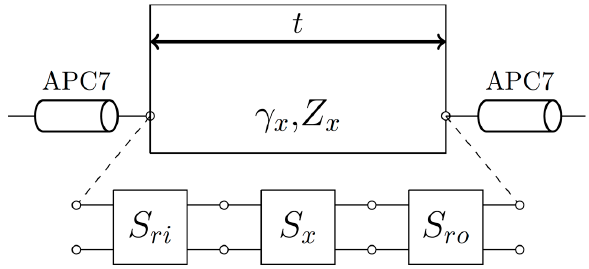
Figure 10. Schematic representation of the assembly.